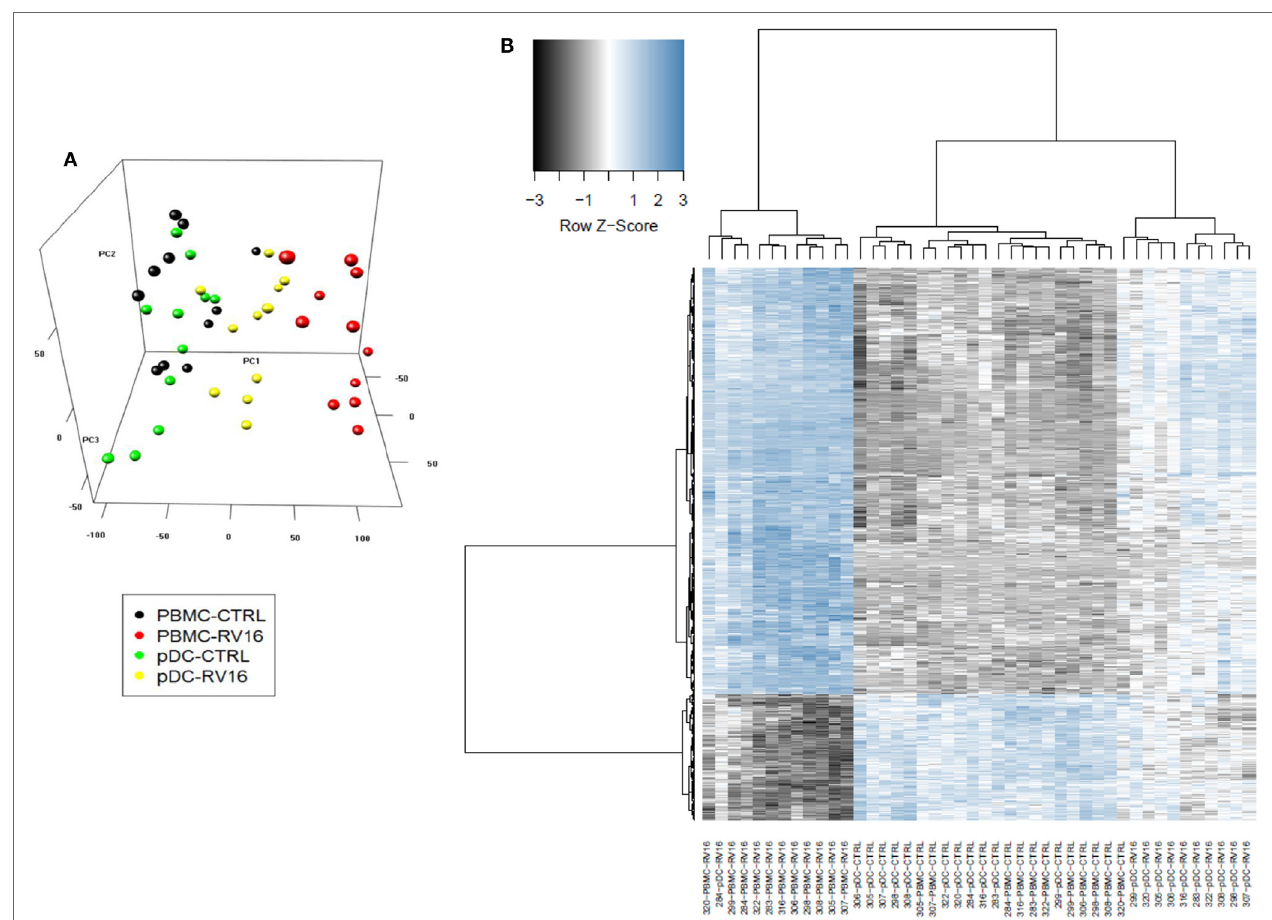
FigUre 2 | In the presence of human rhinoviruses strain 16 (RV16), intact peripheral blood mononuclear cell (PBMC) and plasmacytoid dendritic cell (pDC)- depleted PBMCs exhibit distinct patterns of gene expression. Intact PBMC and pDC-depleted PBMC ( n = 12) were cultured with/without RV16 for 24 h. Whole- genome transcriptional profiling was performed using Illumina Human HT-12 microarray. Hierarchical cluster analysis was employed to cluster genes and samples based on the similarity of their expression patterns. RV16 response patterns in PBMC and pDC-depleted PBMC from healthy individuals ( n = 11) were analyzed by principal component analysis. RV16-stimulated PBMC are shown in red, unstimulated PBMC are black circles. RV16-stimulated pDC-depleted PBMC are shown in yellow, and unstimulated pDC-depleted PBMC are green circles (a) . The heatmap illustrates the distinct difference in the RV16 induced gene expression in PBMC and pDC-depleted PBMC (B)